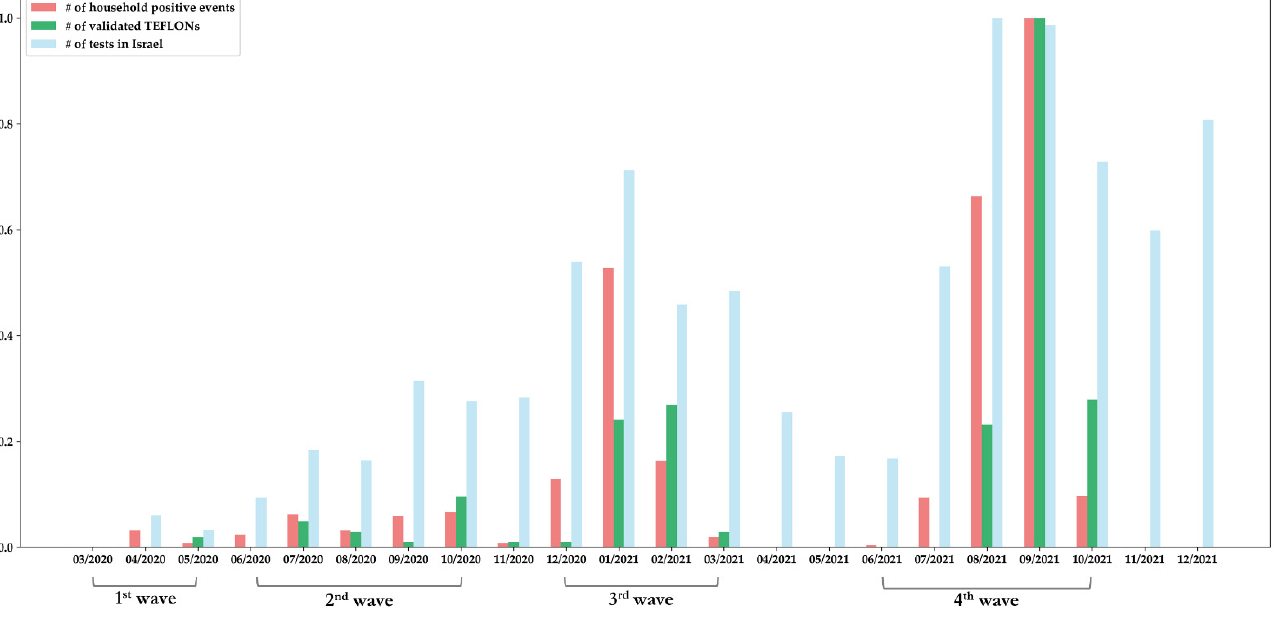
Figure 5. The timeline of SARS-CoV-2 waves in Israel, depicted by quantities of monthly tests [19] (light blue) compared to individual positive events (red) and the number of TEFLON (Timely Exposed to Family members Leaving One Not infected) validations per month. All the counts were scaled to a common 0–1 range.